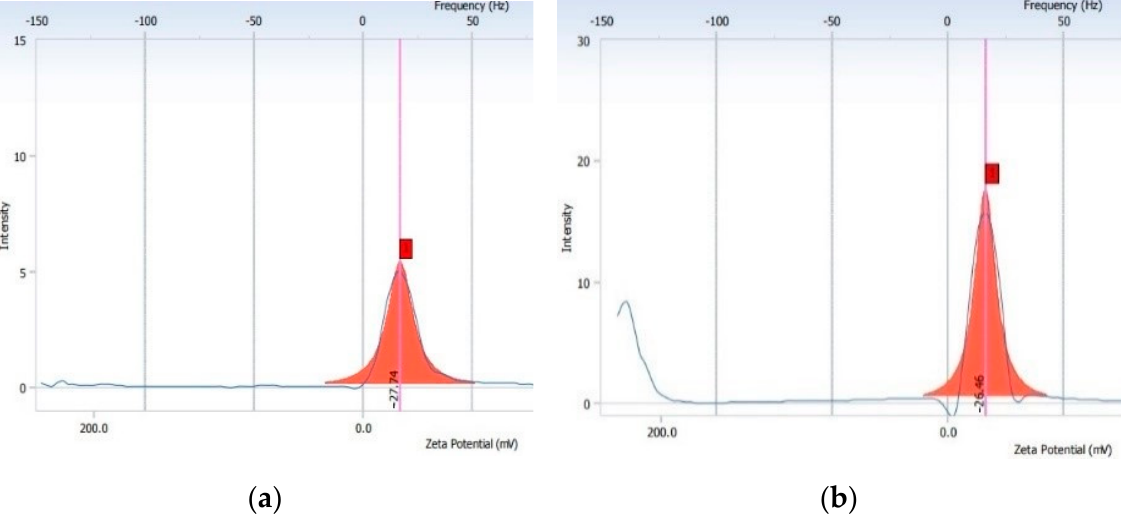
Figure 14. Zeta potential of AgNPs-H 2 O ( a ) and of AgNPs-EtOH ( b ) .